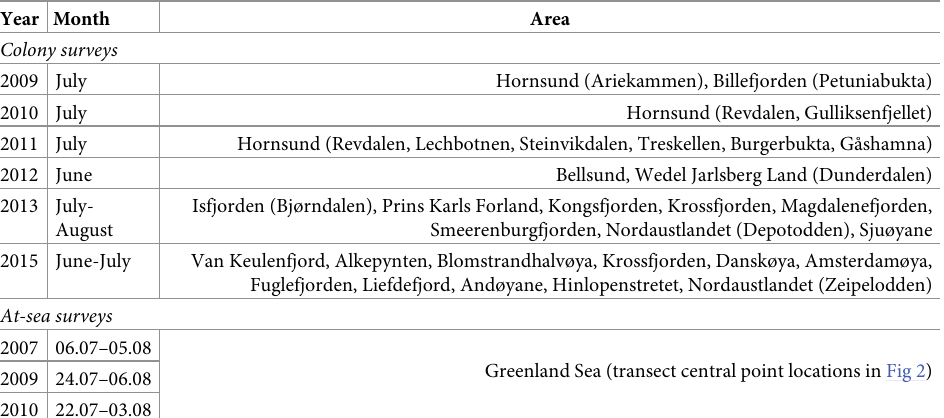
Table 1. A summary of surveyed little auk colonies and at-sea surveys performed during this